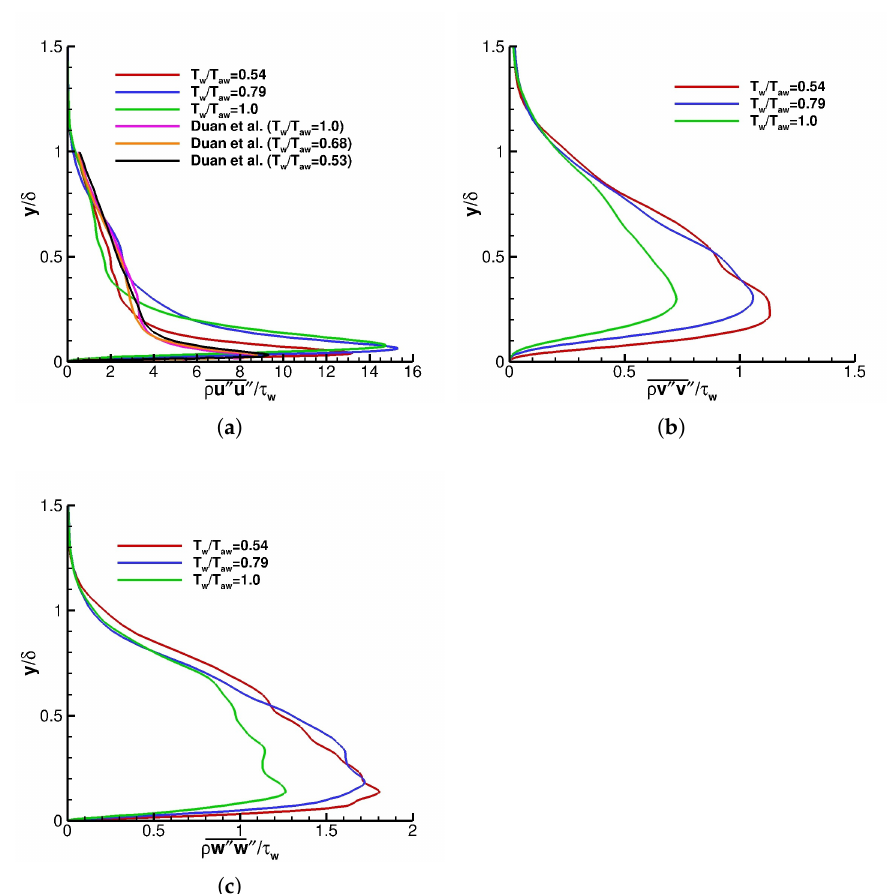
Figure 15. Effect of wall temperature on Morkovin scaled dimensionless turbulent normal stresses at x / δ = 20 for: ( a ) Streamwise direction. ( b ) Wall normal direction. ( c ) Spanwise